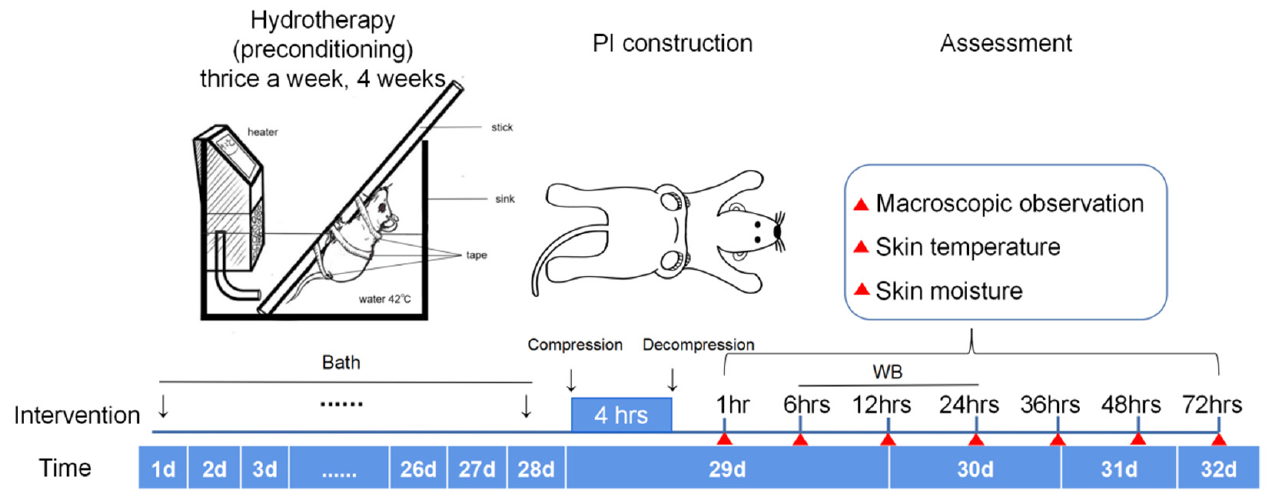
Figure 6. Protocol of the study design. PI: pressure injury. WB: Western